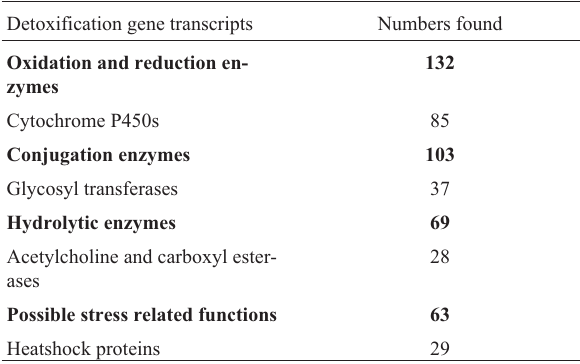
Table 2 - Detoxification genes expressed in the reference